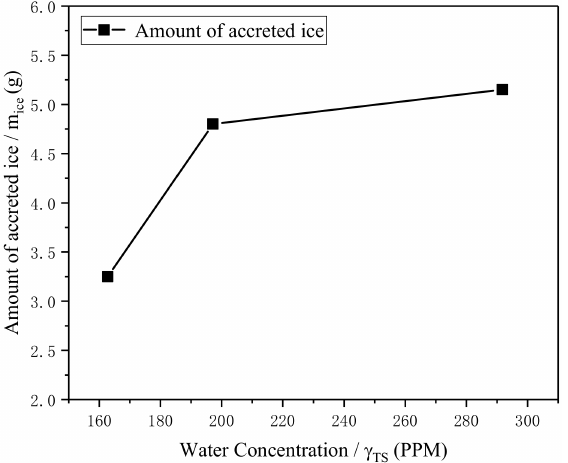
Figure 12. Mass of accreted ice in the upstream test section versus the water